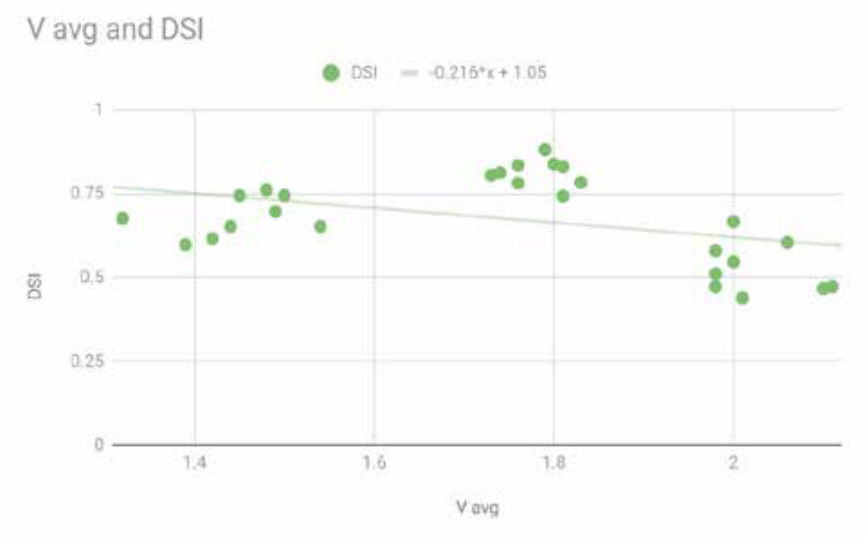
Fig. 3. Vavg and DCI Correlation